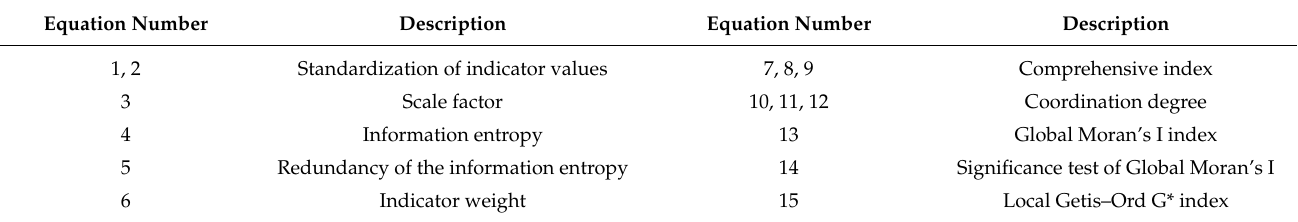
Table 3. List of equations.